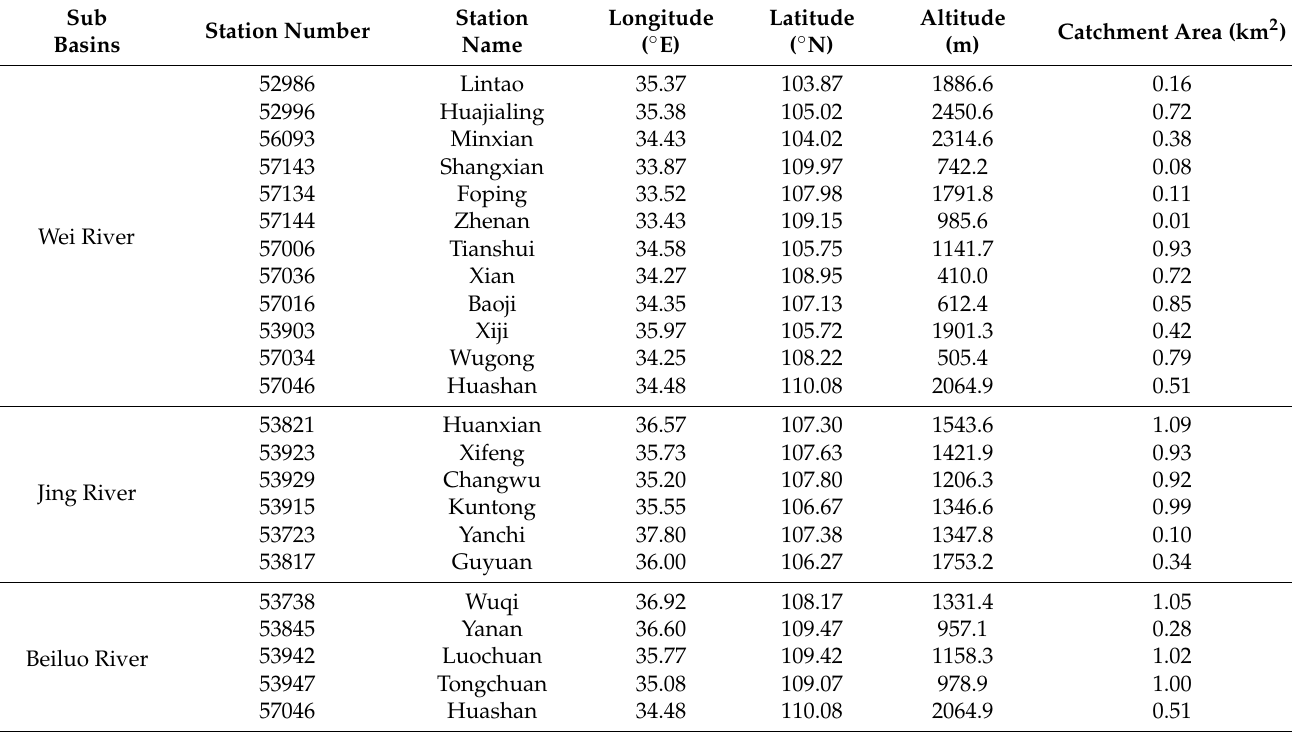
Table 1. Information for the National Meteorological Observatory Stations used in this study.